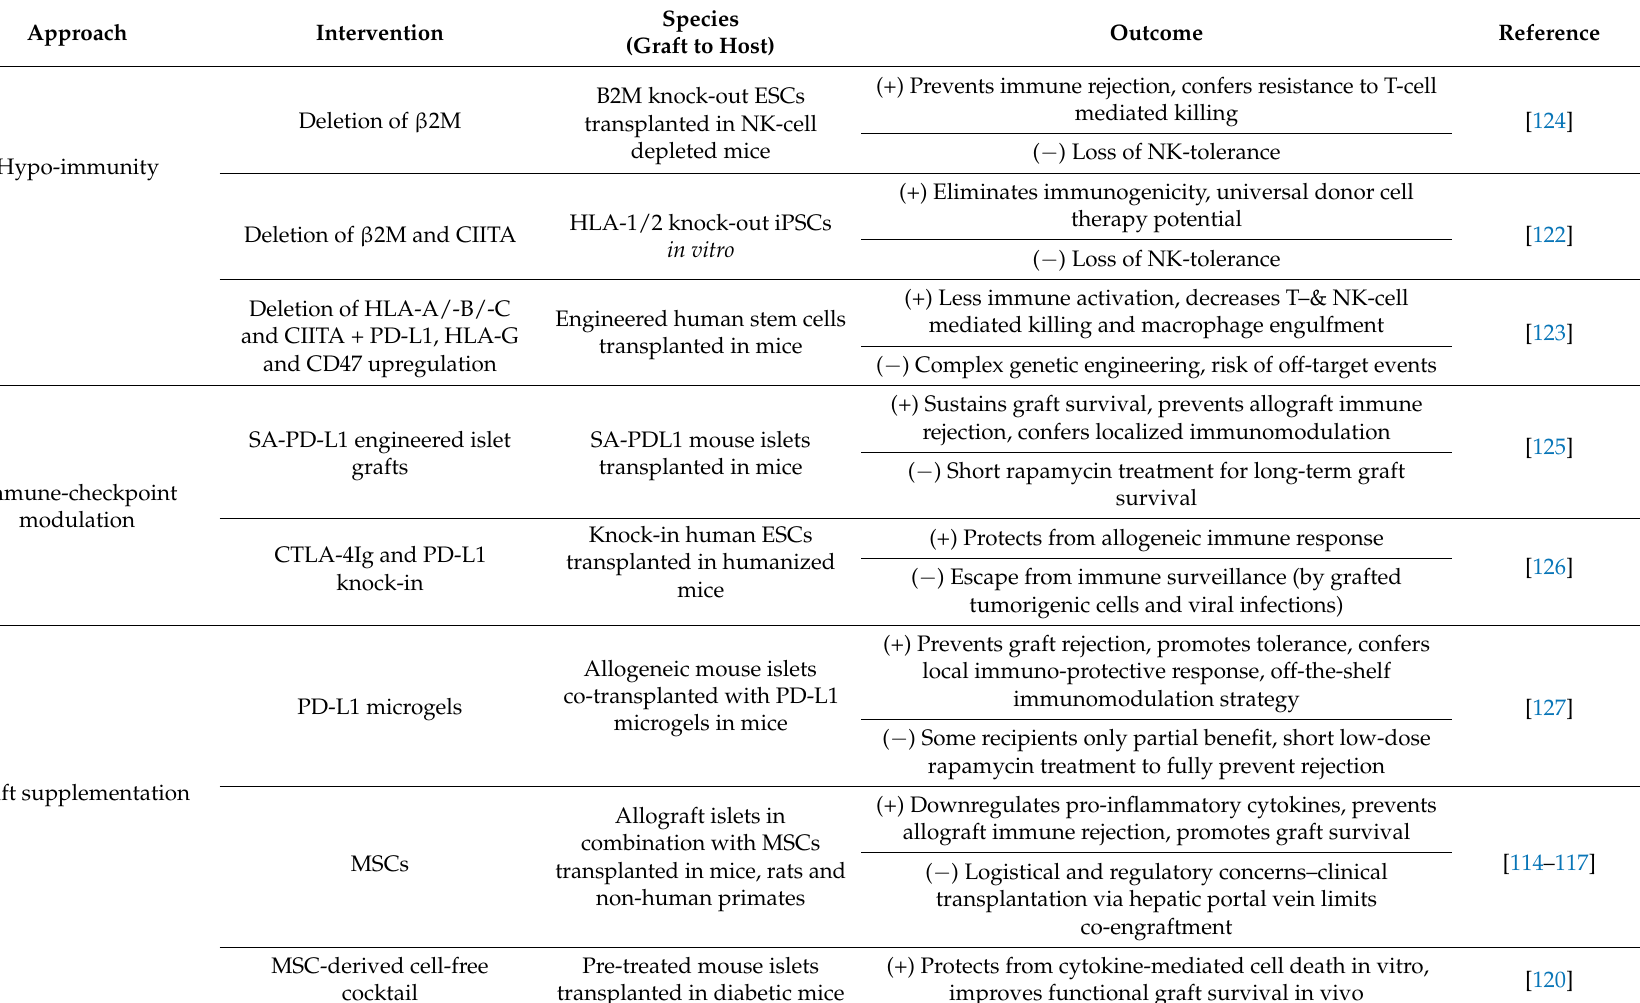
Table 3. Approaches to prevent immune rejection of stem cell-derived